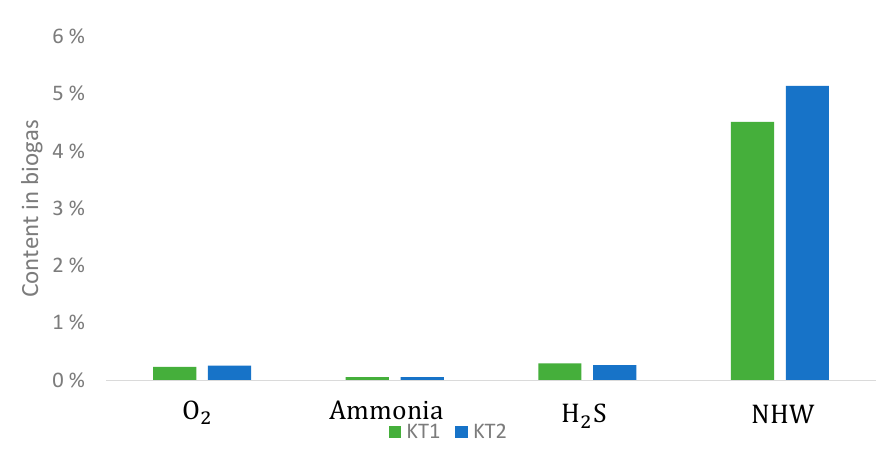
Figure 4. Performance of two models of biogas plants.